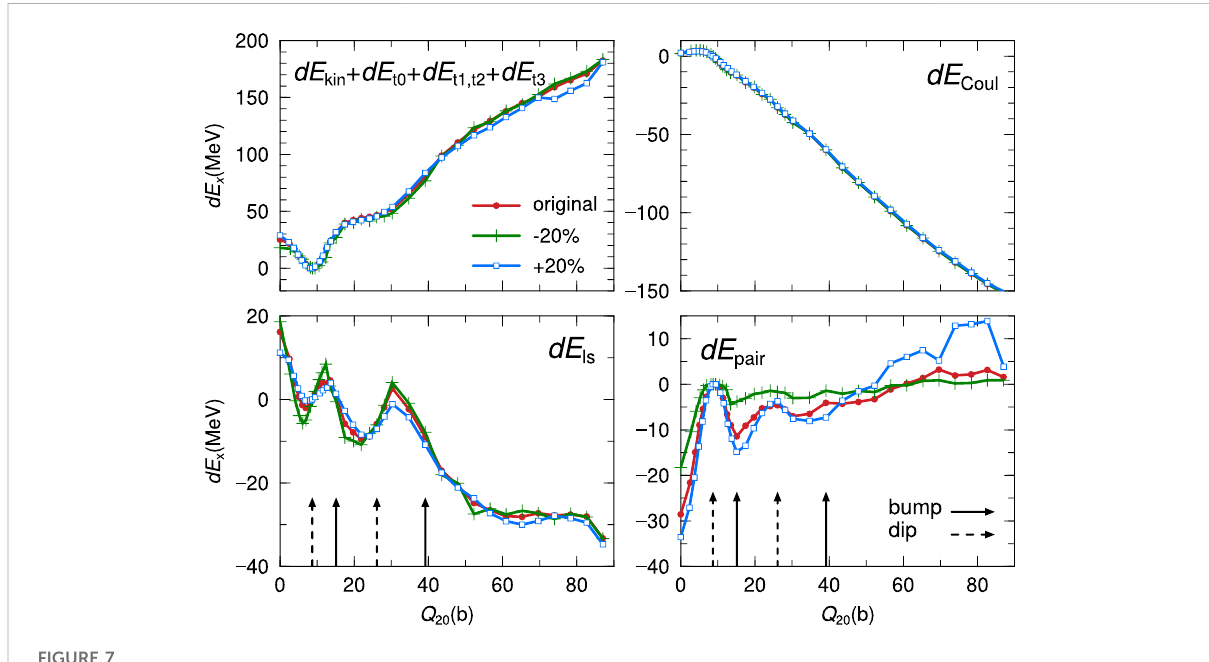
FIGURE 7 Same as Figure 4, but for SkM* with three choices of the pairing strength G